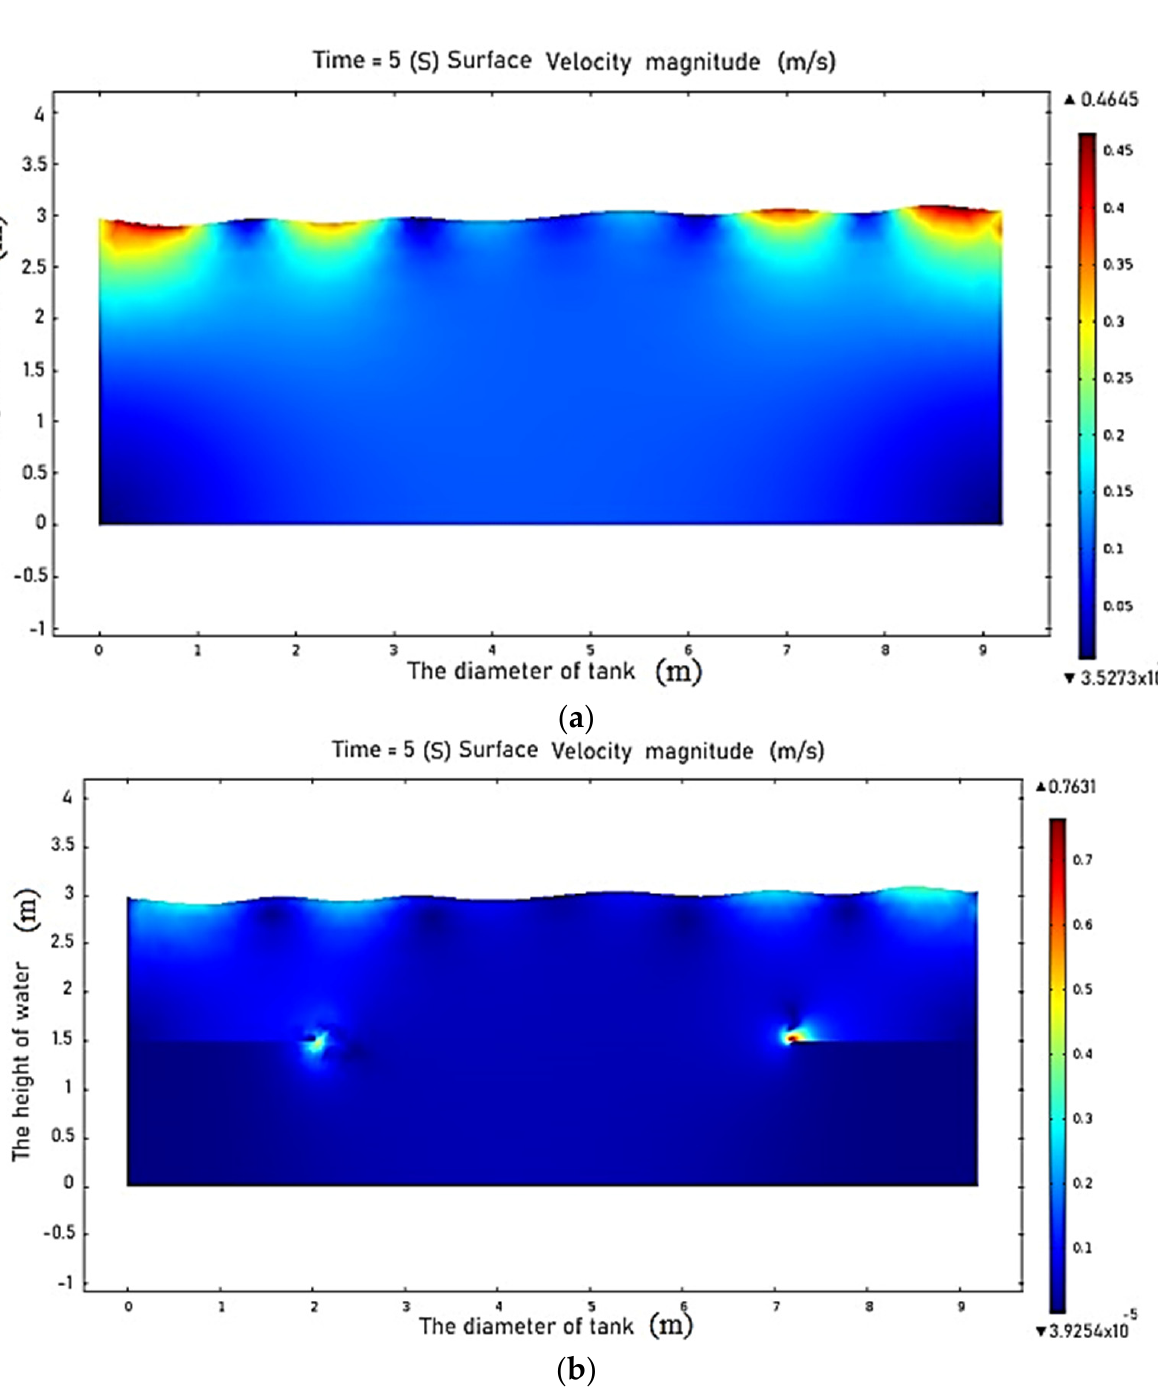
Figure 9. Two-dimensional diagram sloshing of the fluid surface with/without baffle. ( a ) Two-di- mensional diagram of the no baffle sloshing of the fluid surface at T = 2 (s); ( b ) two-dimensional diagram of the baffle sloshing of the fluid surface at T = 2 (s).